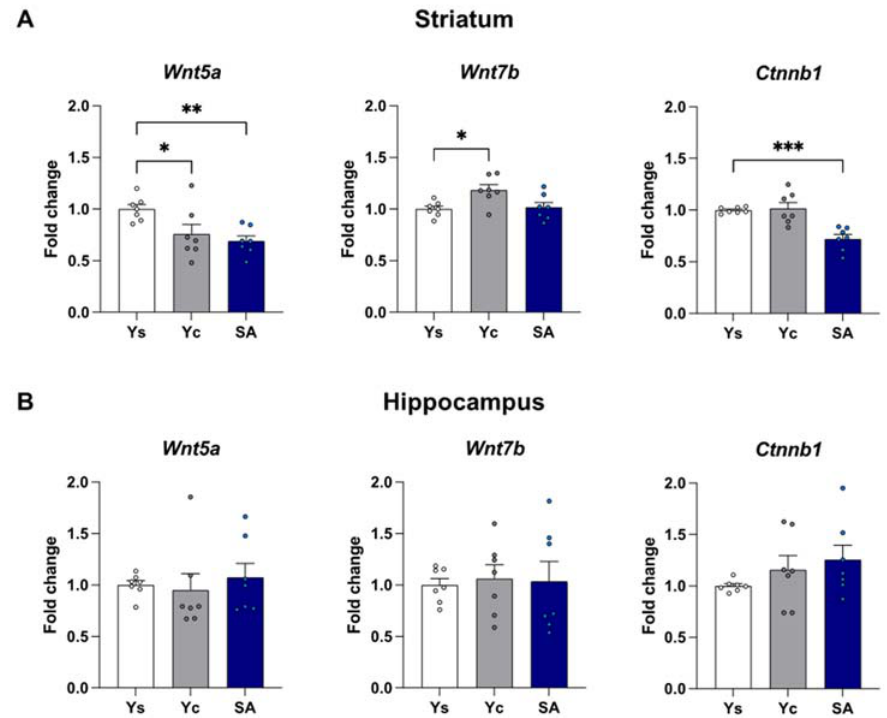
Figure 3. The mRNA expression levels of Wnt5a , Wnt7b , and Ctnnb1 in the striatum ( A ) and hippocampus ( B ) after 3 days of extinction training. n = 7 rats/group. Significance was determined using a one-way ANOVA and the post hoc Dunnett’s test. * p < 0.05, ** p < 0.01, *** p < 0.001 versus the yoked saline (Ys) control group. SA: cocaine self-administration group; Yc: yoked cocaine group.